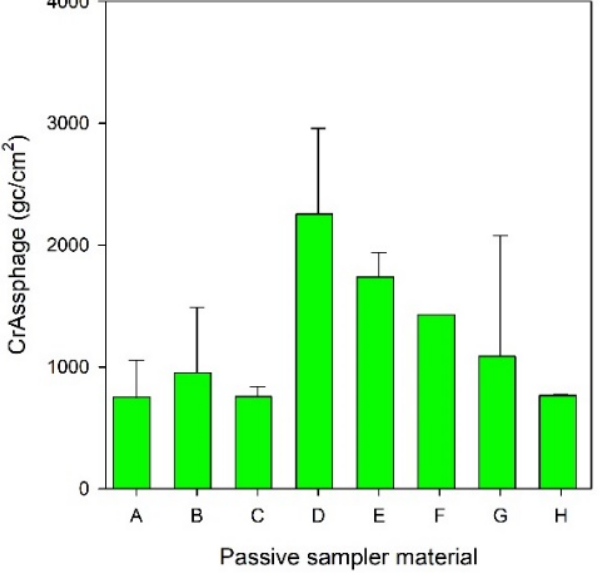
Figure 2. Recovery of the faecal marker virus crAssphage from wastewater by 8 different passive sampler materials after incubation in the field for 1 h. Values represent means ± SEM ( n = 3). The alphabetical key to the different passive sampler materials is presented in Table 1. gc: genome copies.